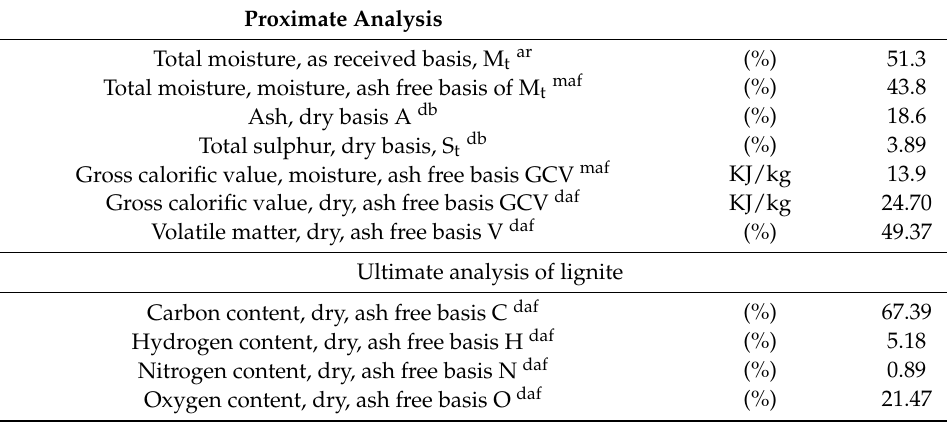
Table 3. Proximate and ultimate analysis of lignite from the Szczerc ó w deposit.